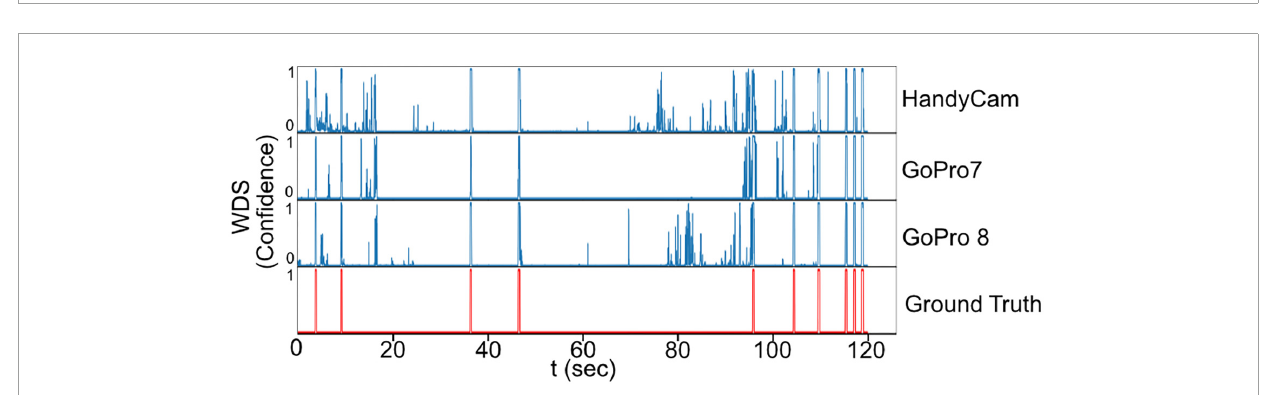
FIGURE7 Raw classification prediction in a 2 min video sample. Numerous false positives are detected.